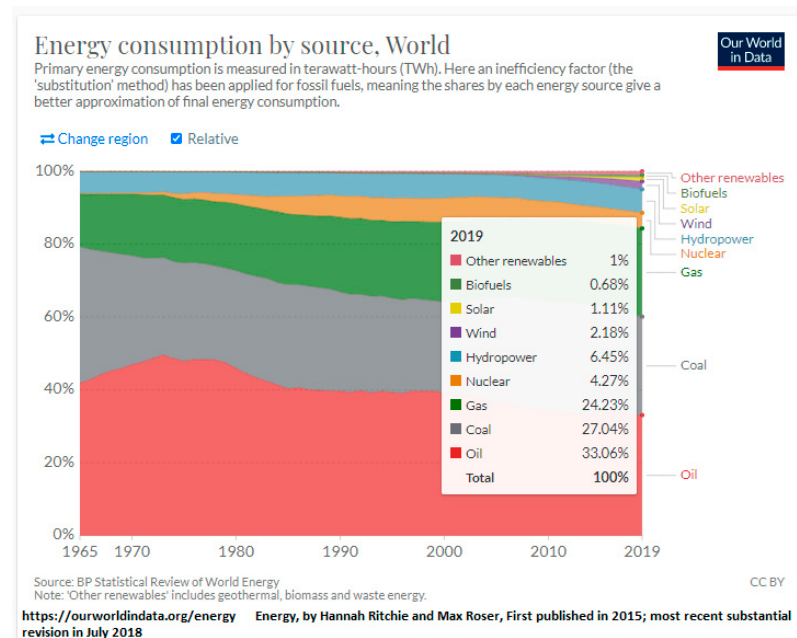
Figure 1. Energy consumption in the world, 2019.